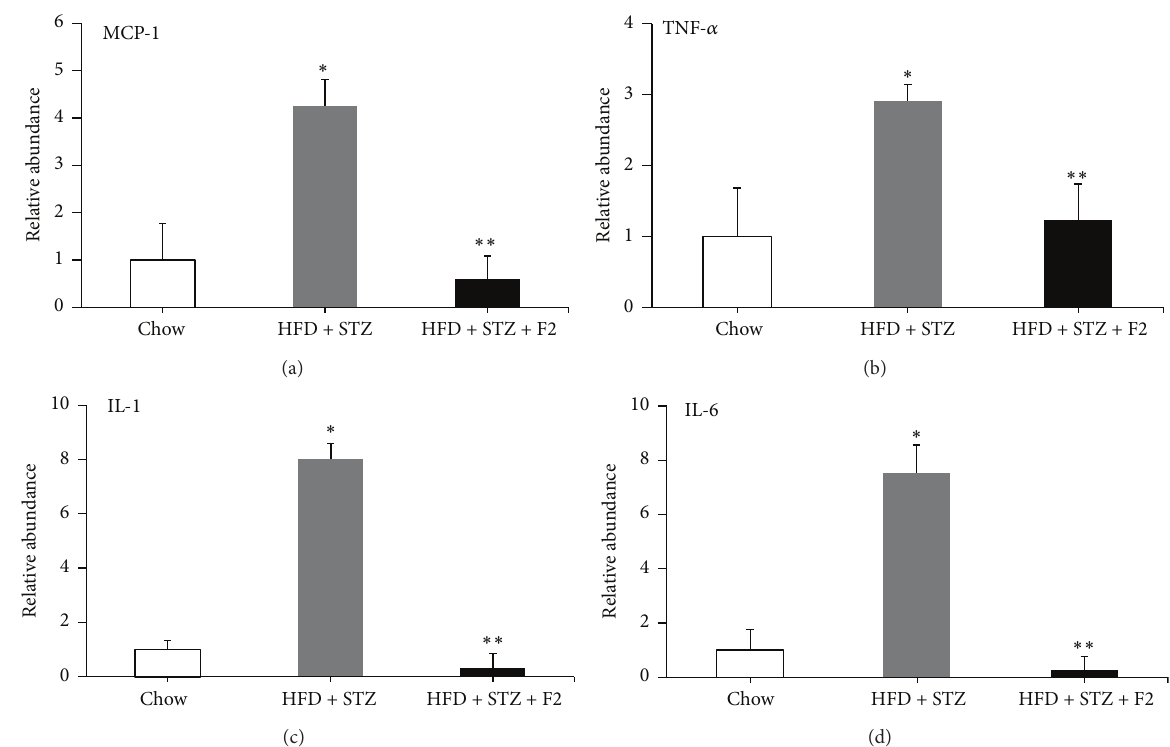
Figure 3: Effect of F2 on adipose expression of proinflammatory cytokine genes. mRNA expression levels by qRT-PCR of MCP-1 (a), TNF- 𝛼 (b), IL-1 𝛽 (c), and IL-6 (d) in adipose tissues of F2 treated diabetic mice. HFD + STZ: diabetic control group and HFD + STZ + F2: diabetic group given 10 IP doses of ethyl acetate fraction (F2). ( 𝑛 = 6 .) ∗ 𝑝 < 0.05 versus control and ∗∗ 𝑝 < 0.05 versus HFD + STZ group. Values are expressed as mean ± SEM.